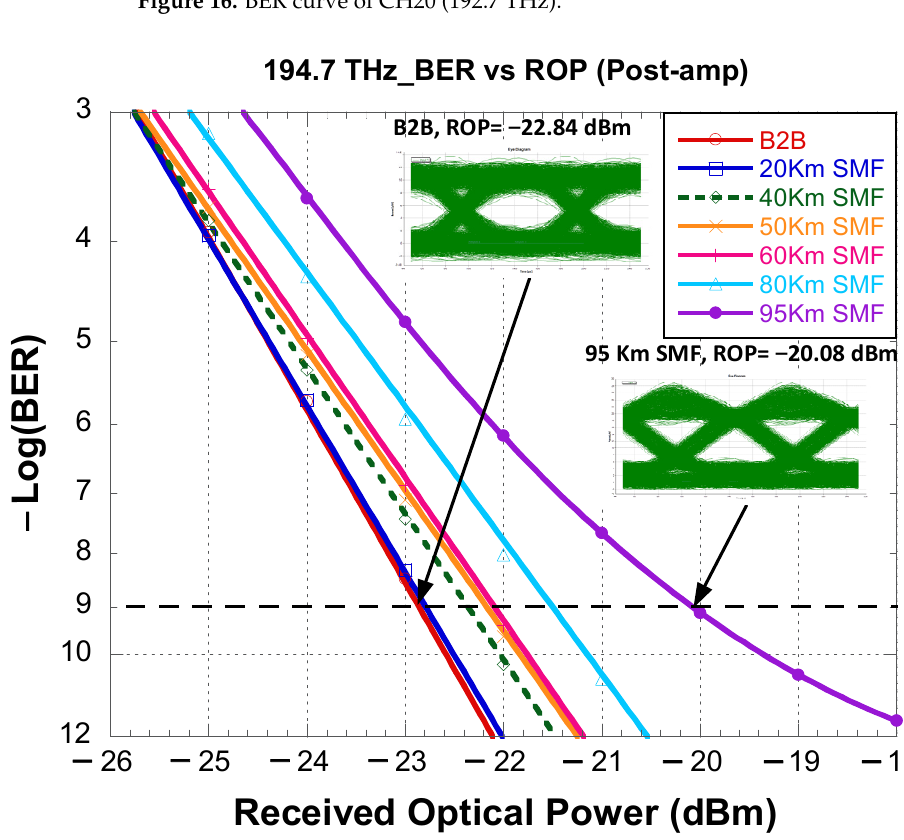
Figure 17. BER curve of CH40 (194.7 THz).